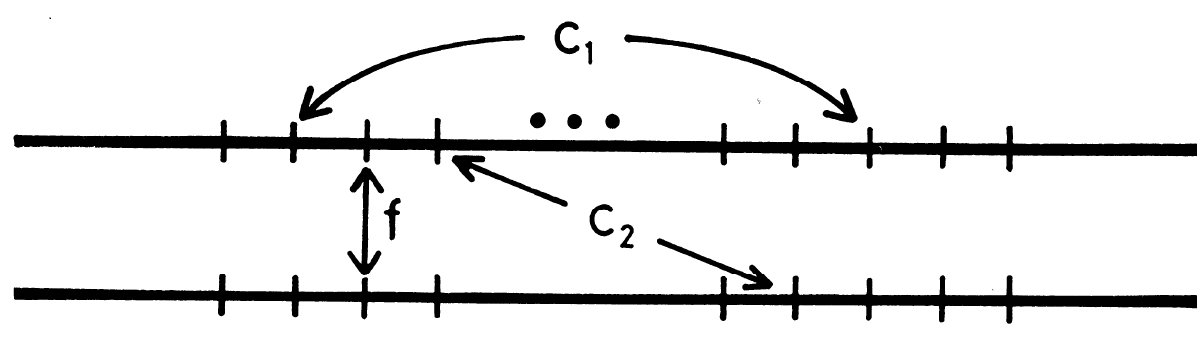
Figure 1. Diagram showing the meaning of the three identity coefficients for concerted evolution (from